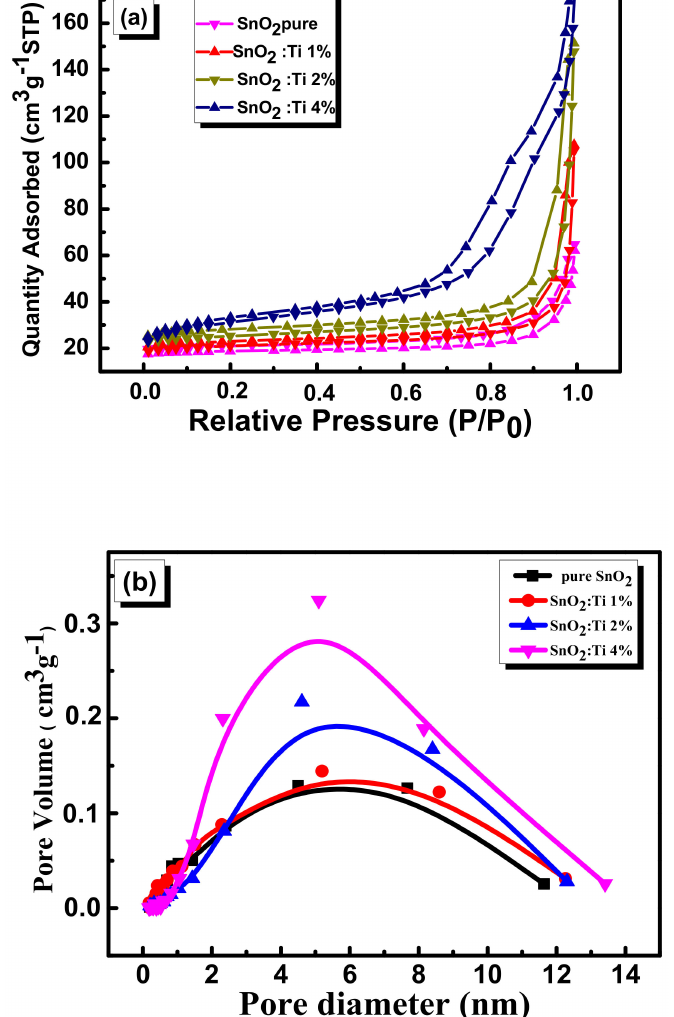
Figure 5. Nitrogen adsorption-desorption isotherms of Ti- SnO 2 NPs ( a ), Pore size distribution of Ti-SnO 2 NPs ( b